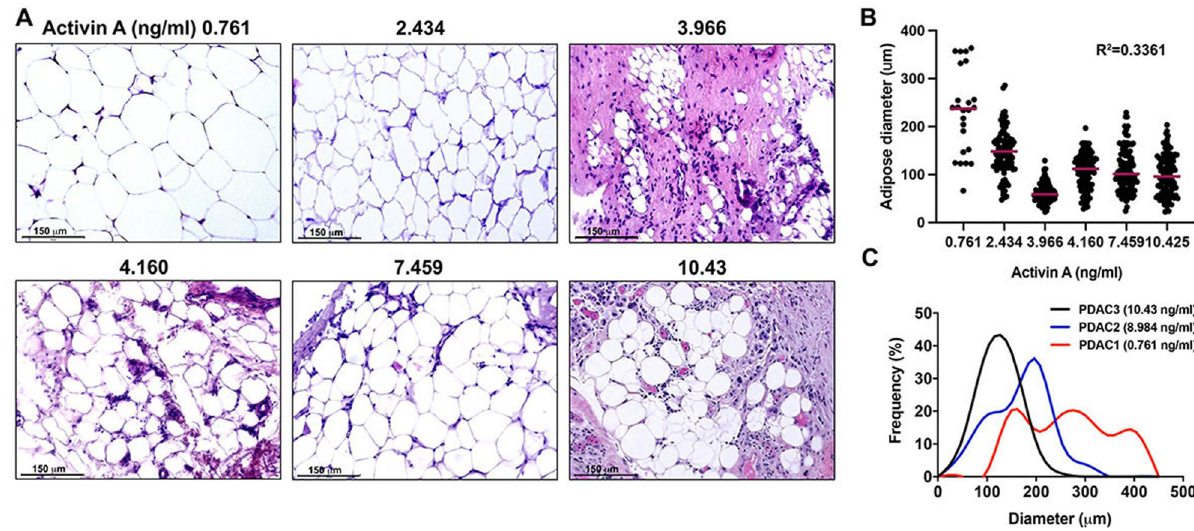
Figure 2. Serum activin A levels can be correlated with loss of visceral adipose tissue in PDAC patients. ( A ) H&E images of visceral adipose tissue from PDAC patients with corresponding activin A levels in ng/ml. Scale bar = 150 µm. ( B ) Measurement of adipocyte diameter in visceral adipose tissue from PDAC patients. The diameters of adipocytes were measured from several histological sections. 6 sections, 0.761 ng/ml; 14 sections, 2.434 ng/ml; 14 sections, 3.966 ng/ml; 11 sections, 4.160 ng/ml; 10 sections, 7.459 ng/ml; 6 sections, 10.425 ng/ ml. Corresponding serum activin A levels are included in ng/ml. ( C ) Frequency curve of adipocyte diameter in visceral adipose tissue from patients with low serum activin A (0.761 ng/ml, red line), elevated serum activin A (8.984 ng/ml, blue line), and increasingly elevated serum activin A (10.425 ng/ml, black line). The diameters of adipocytes were measured with 6 histological sections